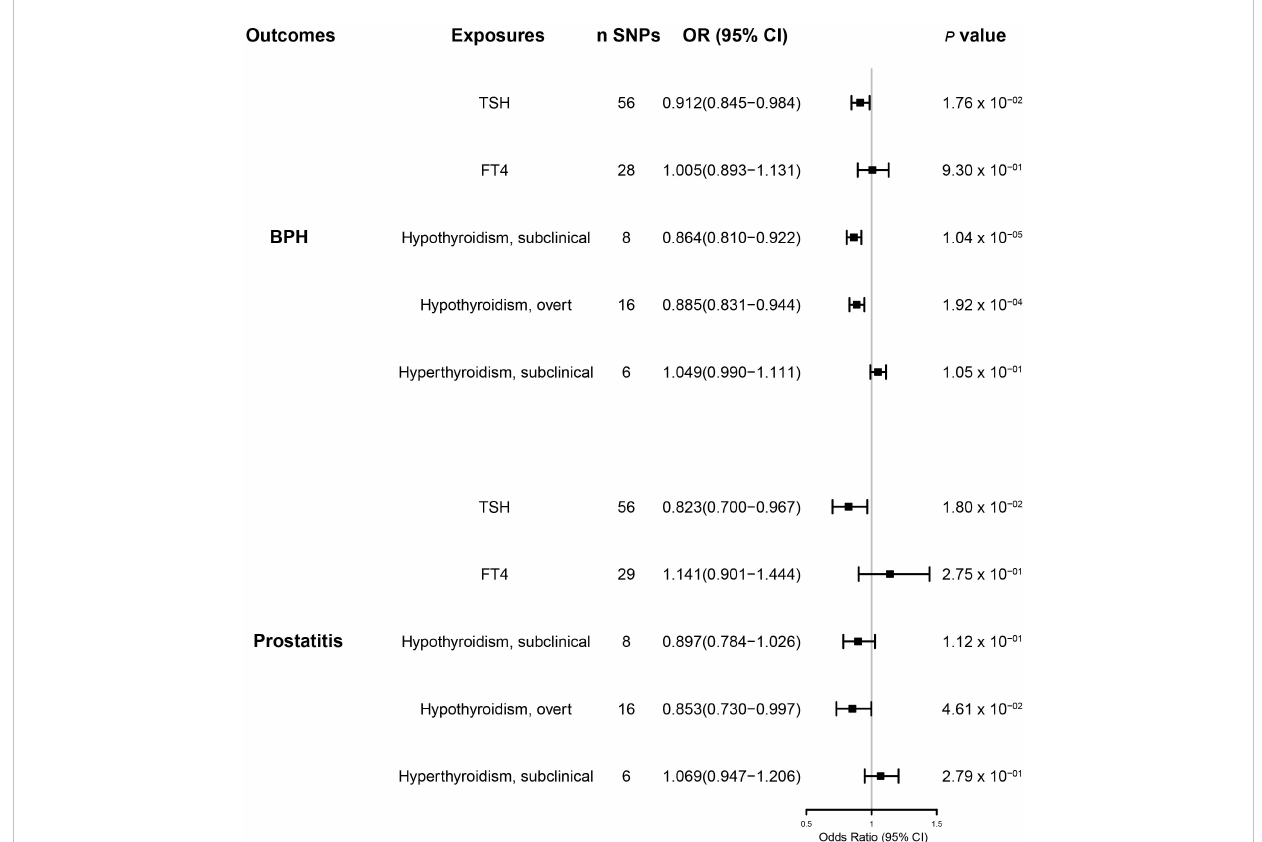
FIGURE 2 The results of the inverse variance weighted method to assess the causal role of thyroid function in the risk of benign prostatic hyperplasia and prostatitis. BPH, benign prostatic hyperplasia; CI, con fi dence interval; SNPs, single-nucleotide